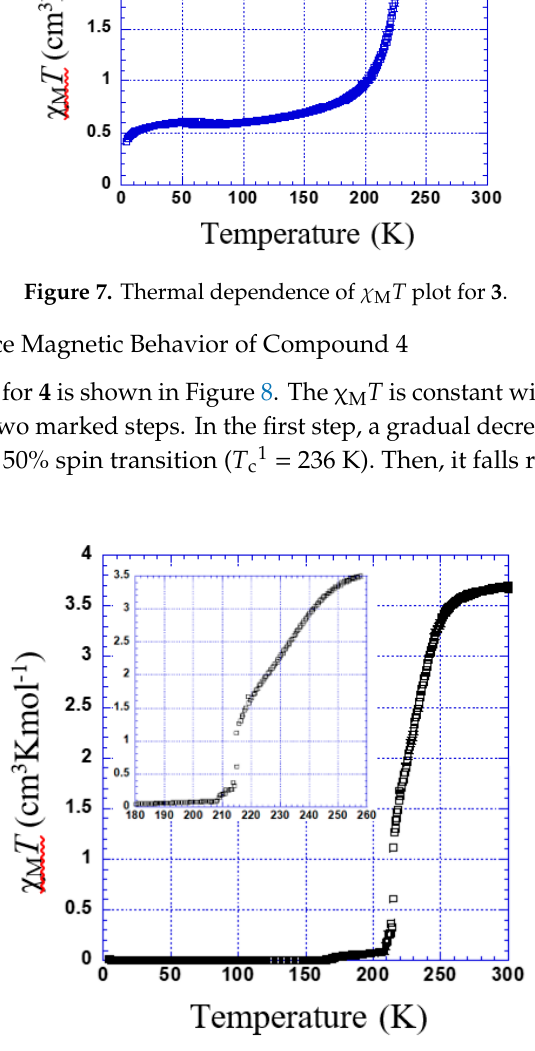
Figure 8. Thermal dependence of χ M T plot for 4 . Inset shows the temperature range of 180 to 260 K.